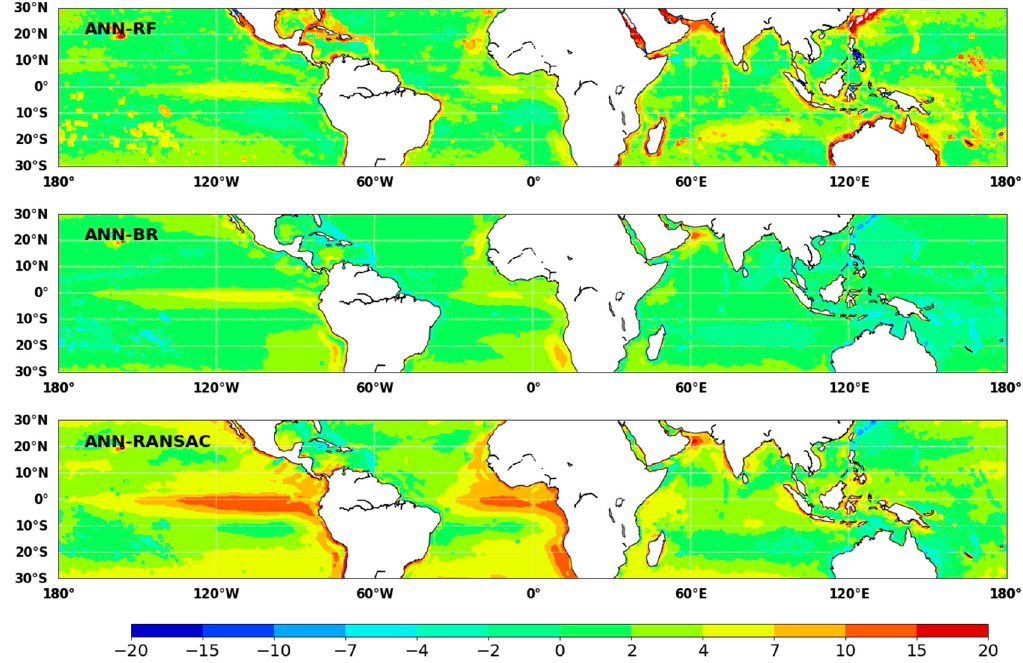
Figure 11. Maps of spatial difference in annual average ocean LHF between ANN and other ML methods ( RF , BR and RANSAC ) over low-latitude area during 2003–2007 (unit W m − 2 ).